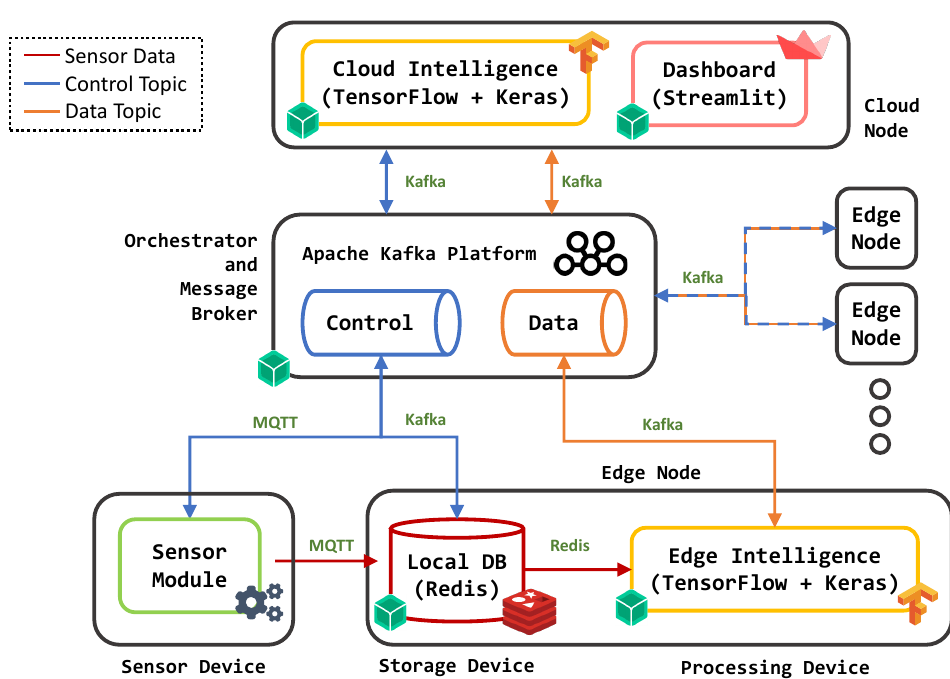
Figure 2. Components of the proposed prototype.